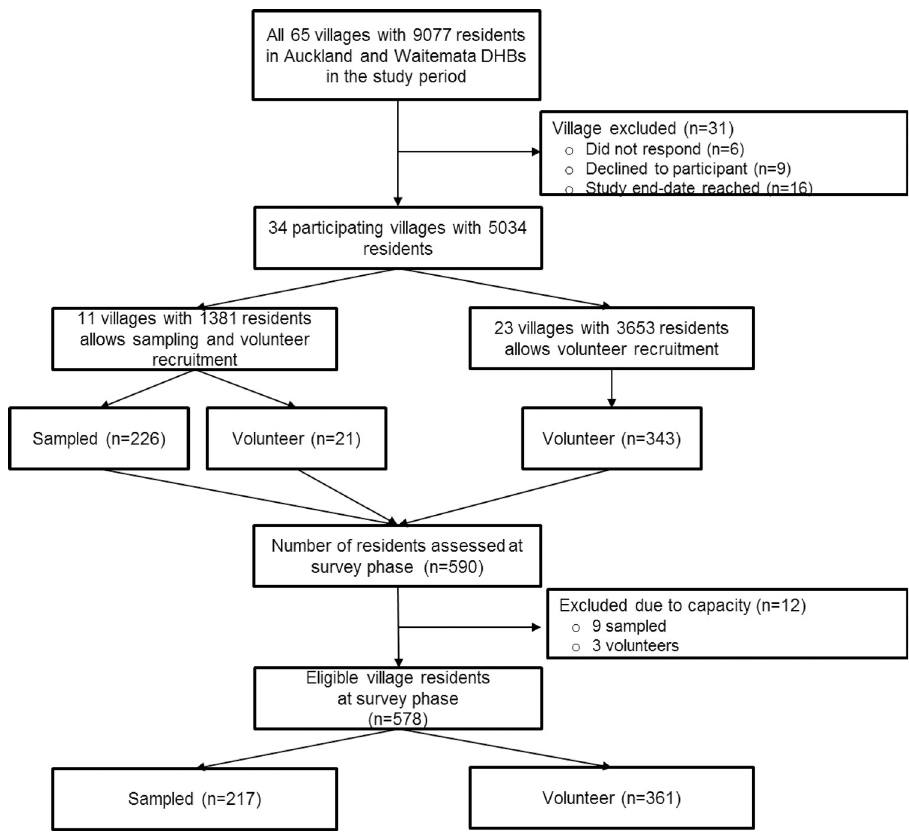
Fig 1. Flow diagram of recruitment of RVs and eligible